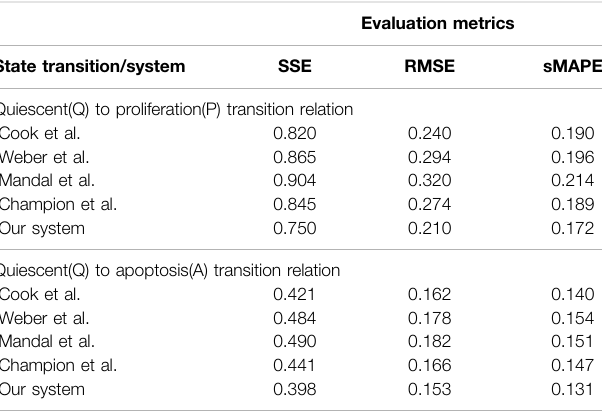
TABLE 5 | Evaluation of the data-driven relation learning systems for extracting phenotypic transitions